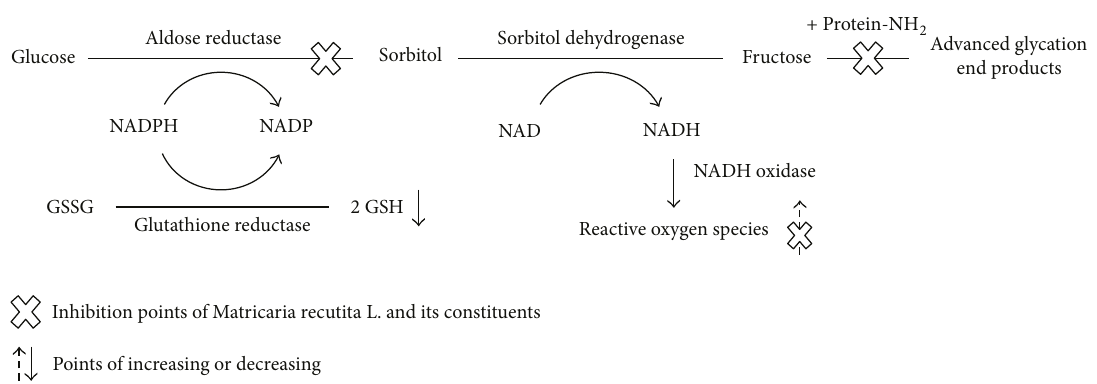
Figure 4: Inhibition points of Matricaria recutita L. and its constituents on polyol pathway. GSH: glutathione; GSSG: glutathione disul fi de; NAD: nicotinamide adenine dinucleotide; NADH: oxidoreductase-induced nicotinamide adenine dinucleotide; NADP: nicotinamide adenine dinucleotide phosphate; NADPH: oxidoreductase-induced nicotinamide adenine dinucleotide